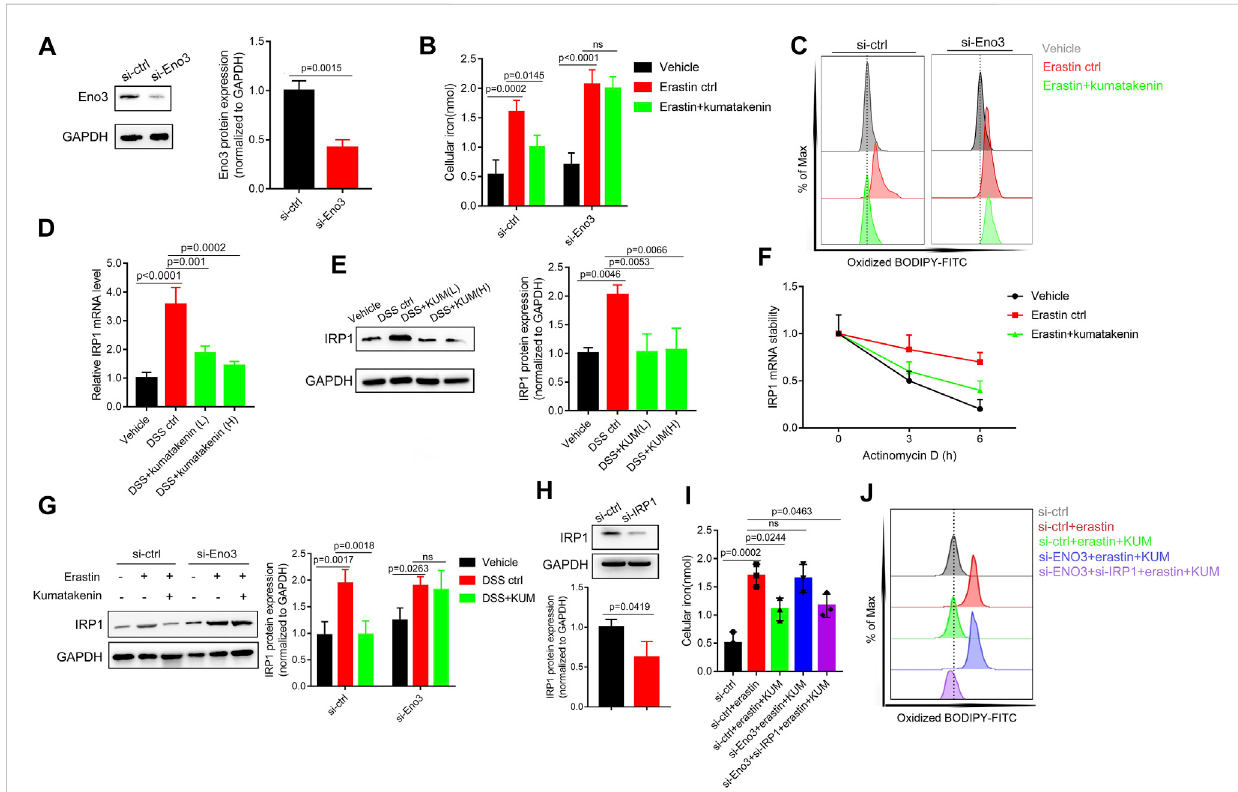
FIGURE 6 Kumatakenin reduced cellular iron levels by activating Eno-3 and inducing degradation of iron regulatory protein 1 (IRP1) mRNA. (A) Examination of Eno3 expression to verify the knockdown ef fi ciency of siEno3. Effects of Eno3 knockdown on kumatakenin-exerted effects on (B) cellular iron levels and (C) lipid ROS invitro . (D,E) Effectsofkumatakenin oncolonic IRP1 mRNA andproteinexpression incolitismice. (F) IRP1 mRNA stability wasdeterminedin erastin-treated MODE-K cells by incubating with the transcription inhibitor actinomycin D (5 μ M). (G) Effects of knockdown of Eno3